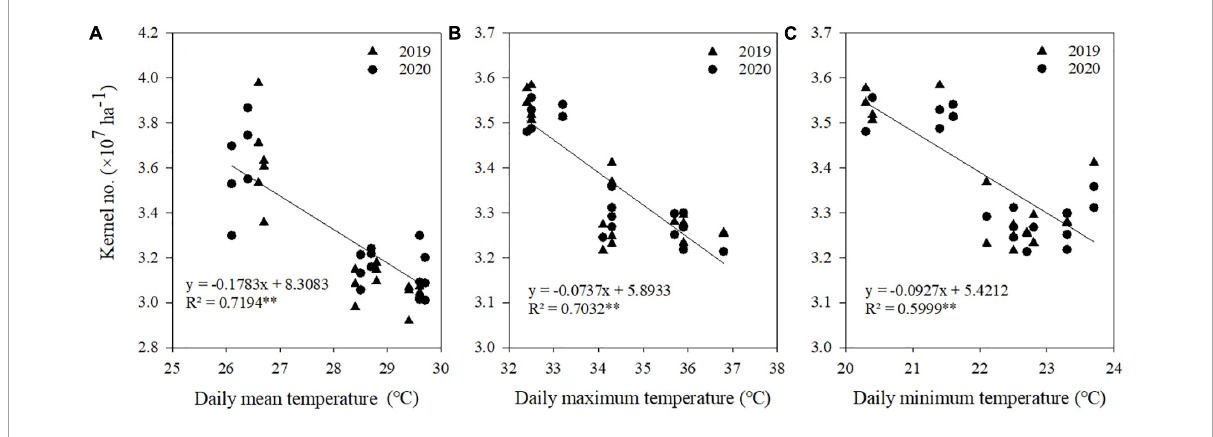
FIGURE5 Relationships between kernel number and daily mean temperature (A) , daily maximum temperature (B) , and daily minimum temperature (C) from V12 to R1. **Significant at the 0.01 probability level.